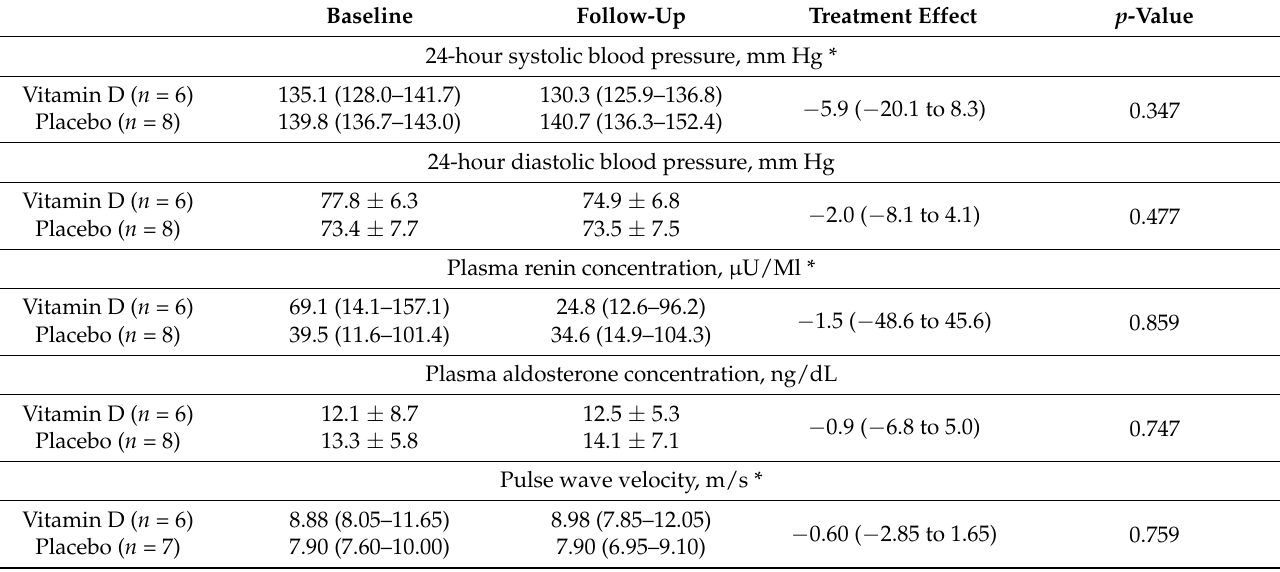
Table 4. Outcome variables at baseline and follow-up and treatment effects in 14 study participants with 25(OH)D < 12 ng/mL who completed the trial (i.e., all of 14 participants with 25(OH)D < 12 ng/mL who had initially been